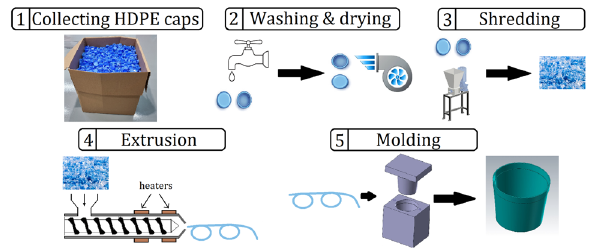
Fig. 1 Global plastics production Source : Plastics Europe Market Research Group (PEMRG) and Conversion Market & Strategy GmbH (W. D’ambri‘eres 2019). The reproduction is permitted Fig. 2 Steps for recycling plastic